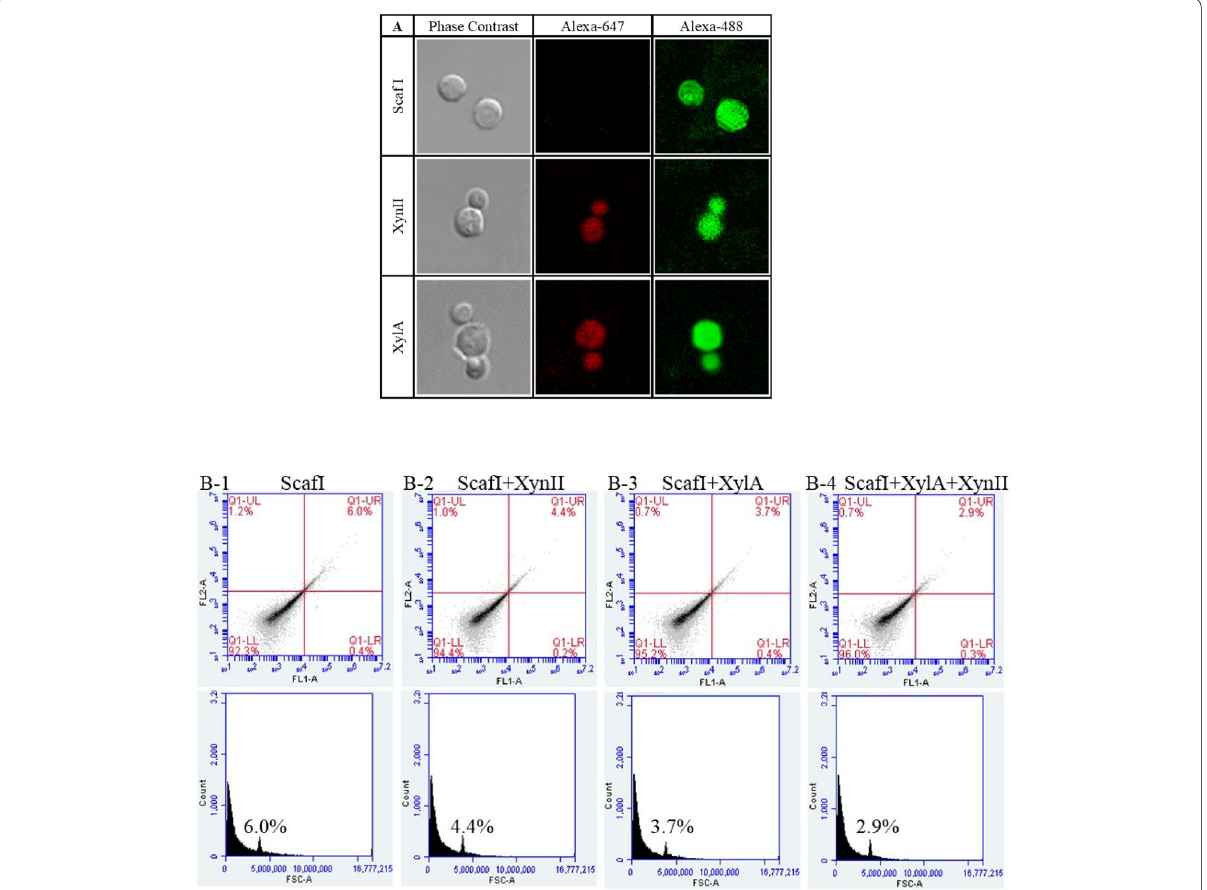
Fig. 4 Functional assembly of yeast surface-displayed cellulosome. A Immunofluorescence micrographs of yeast whole cells displaying the anchoring scaffoldin and docked with enzymes. Cells were probed with anti-Xpress or anti-6 (H L) conjugated with Alexa Fluor 488, Goat anti-Rabbit IgG (H + positive cells displaying different cellulosomal